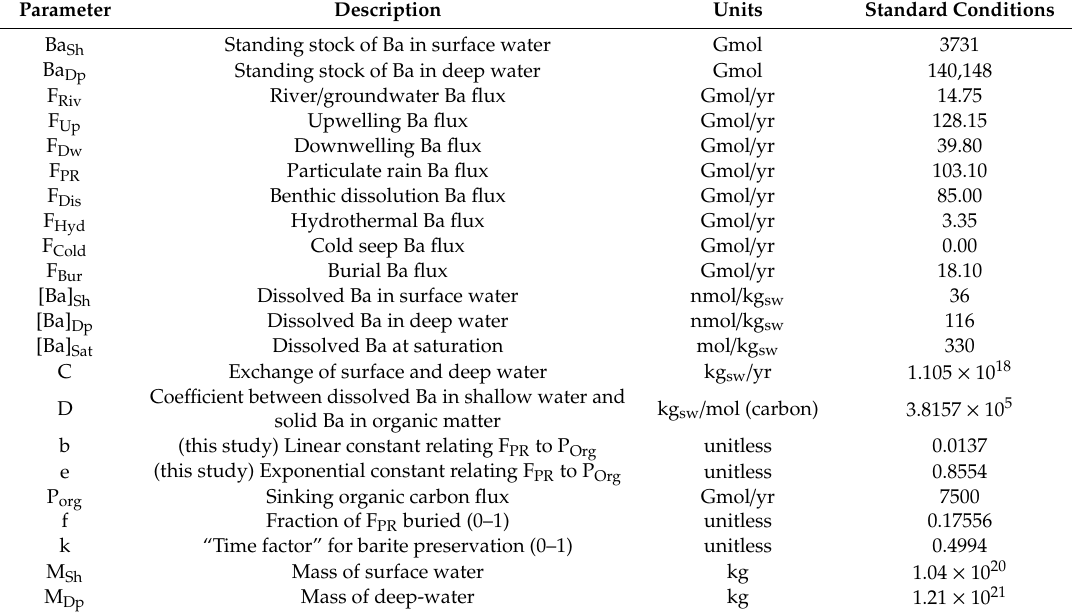
Table 2. List of parameters and constants used to describe the marine Ba cycle from Dickens et al. [27], with the addition of constants ‘b’ and ‘e’ used here in the new formulation of F PR .